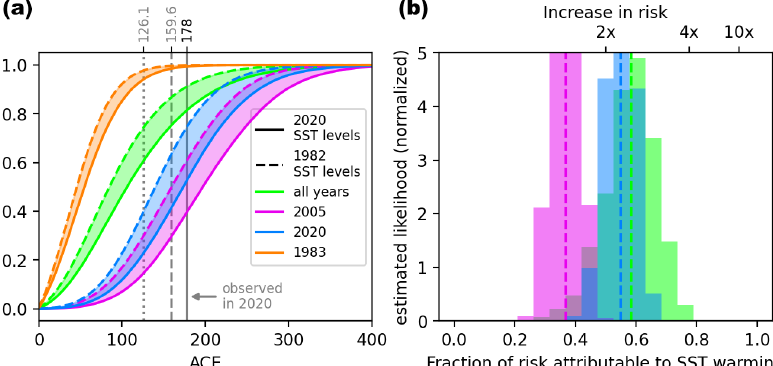
Figure 7. Influence of ocean warming on the hurricane season 2020. (a) Cumulative distribution functions for seasonally aggregated ACE for the 2020 scenario (solid) and the 1982 scenario (dashed). All years between 1982–2020 aggregated in green, 2005 in purple, 2020 in blue, and 1983 in orange. The area between the 2020 scenario and the 1982 scenario is shaded. The horizontal gray lines indicate 178 ACE which was observed in 2020 (solid), the threshold for above-normal seasons 126.1 (dotted) and the threshold for extremely active seasons 159.6 (dashed). (b) Fraction of risk of an ACE > 178 season attributable to the SST difference between the 2020 SST levels and 1982 SST levels (dashed lines). The histograms show the fraction of attributable risk (FAR) distributions from a 10000-member bootstrapping for the 1982 SST level scenario, and the vertical lines indicate the median